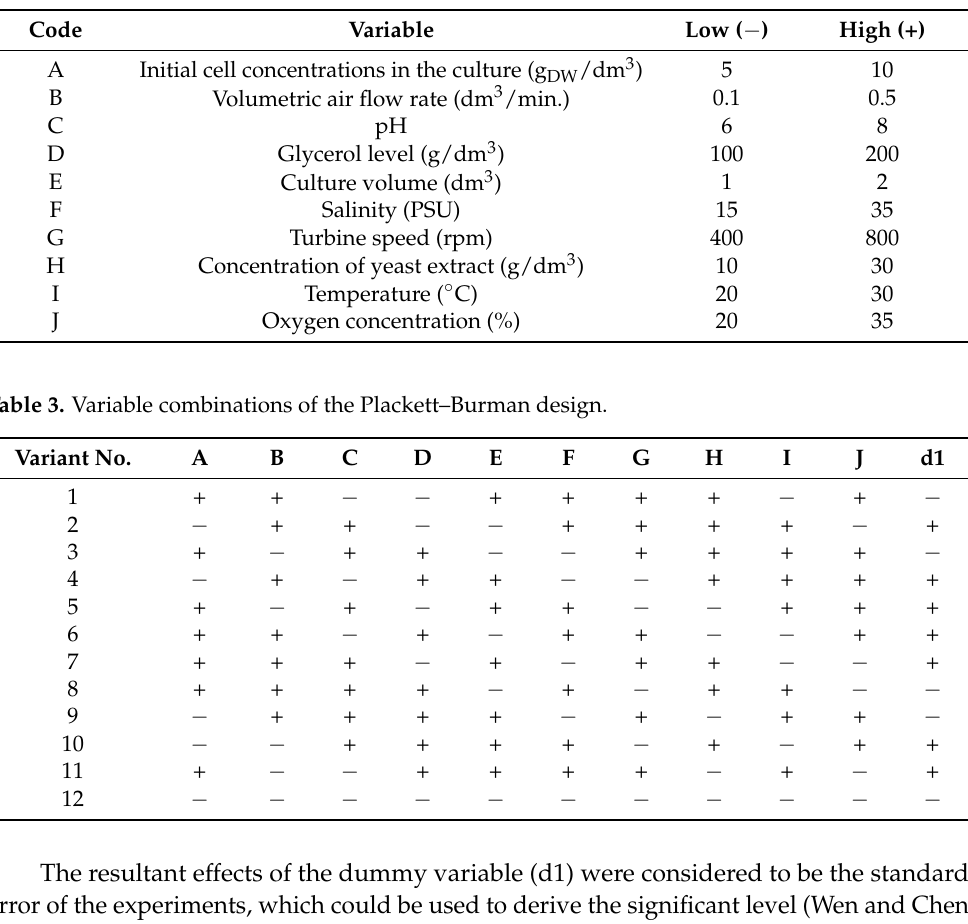
Table 2. Variables screened using Plackett–Burman design.